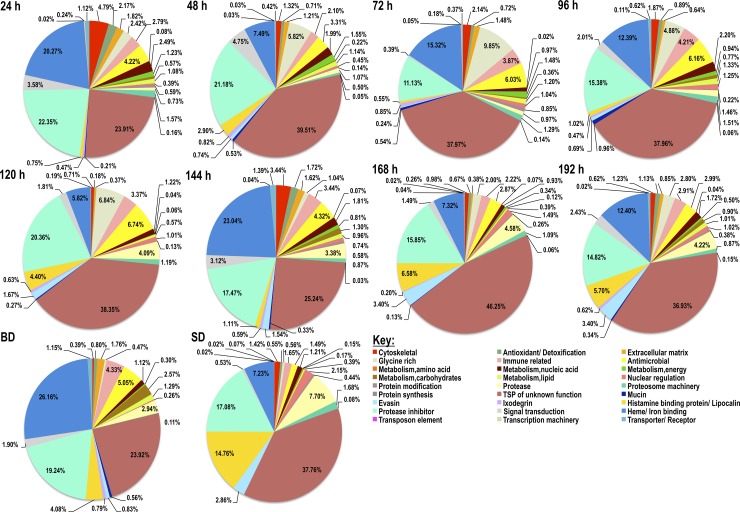
Tick saliva proteins composition in Amblyomma americanum tick saliva every 24 h during feeding.Pilocarpine induced A. americanum tick saliva was subjected to LC-MS/MS sequencing using the “In-Solution” digestion approach as described in materials and methods. Cumulative normalized spectral abundance factors (NSAF) values as index for relative abundance of detected tick saliva proteins are presented for each functional class. Please note the labels are oriented horizontally and read left to right starting from cytoskeletal proteins (red), antioxidant/detoxification (green), extracellular matrix (orange), then back to glycine rich proteins (light-tan), immune related (pink) and continues this pattern.